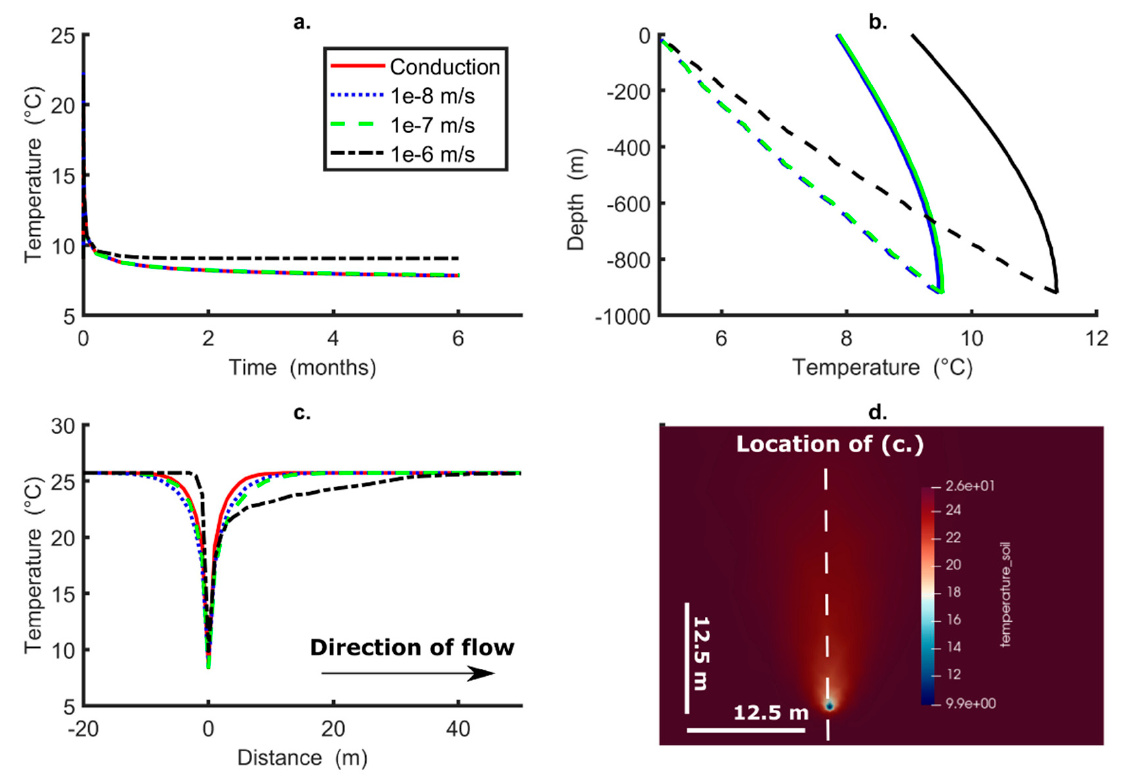
Figure 5. Varying groundwater flows plotted for extraction operation only for 6 months. ( a ) is the evolution of outlet temperature with time (note inlet is set equal to 5 °C), ( b ) is the change in the temperature within the central pipe (solid line) and annulus (dashed line) at the end of the simulation (note that when groundwater flow is set to zero the red line is directly underneath that for the velocity set at 1e-8 m/s), ( c ) is the thermal propagation around the BHE at 500 m depth (BHE is at point zero) and ( d ) is the thermal plume at 500 m depth for a flow velocity of 1e-6 m/s.